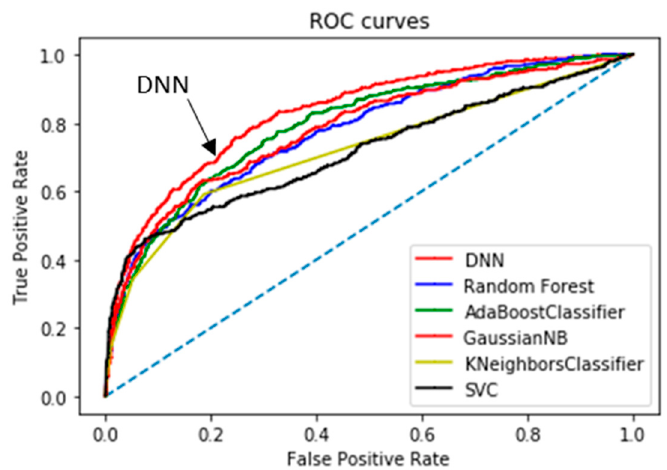
Figure 6. Regarding predictive performance, the area under the receiver operating characteristic curve value was highest (83.48%) for the DNN/scaled PCA classifier. Table 4. Comparison of the performance for six classifiers (10-fold cross-validation). Classifier AUC